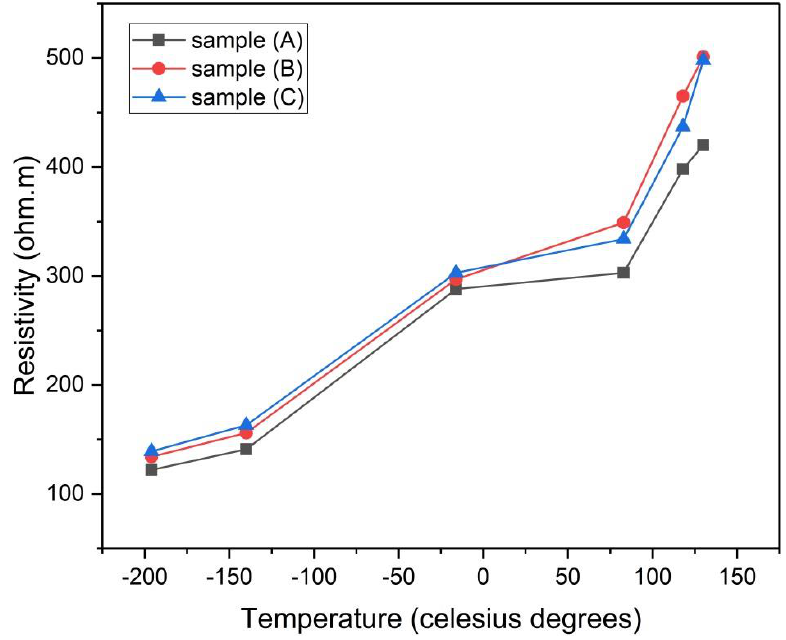
Figure 18. Electrical resistivity of samples (A), (B), and (C) versus the temperature of analysis.